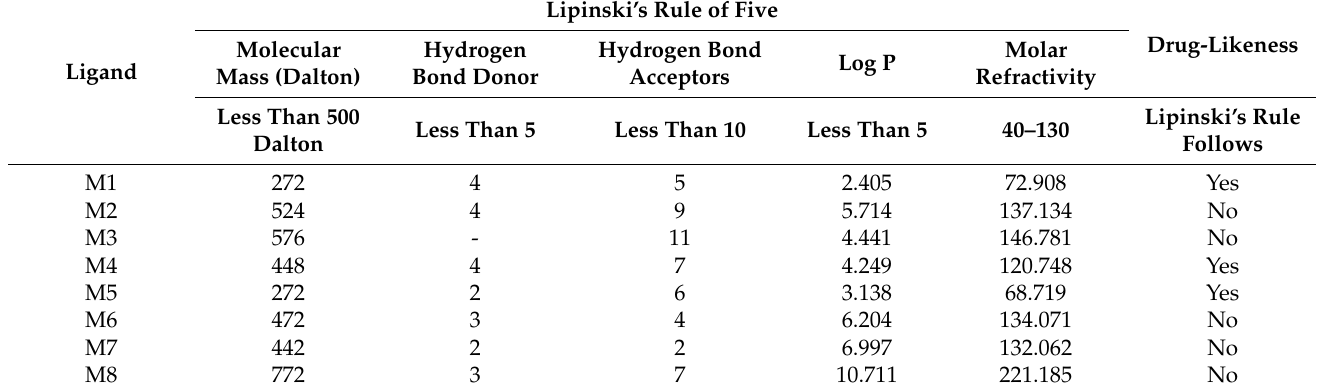
Table 4. Lipinski’s rule result.